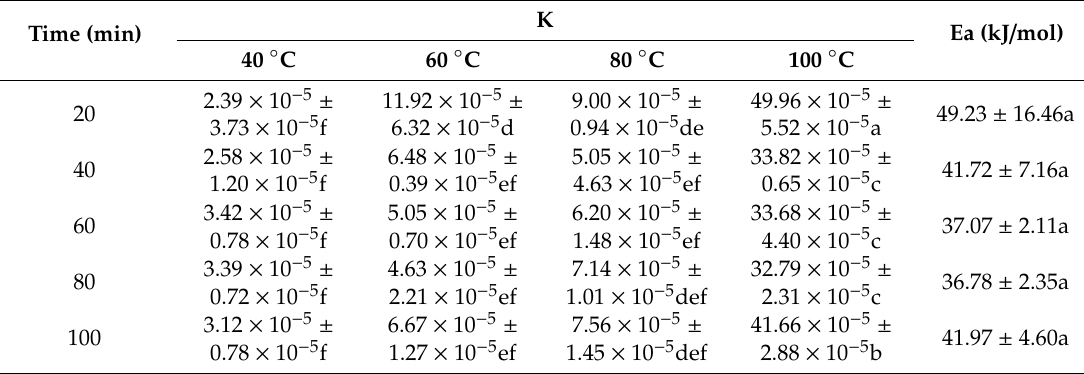
Table 5. E ff ect of temperature and time on the k and Ea values of anthocyanin degradation kinetics of Roselle extracted with